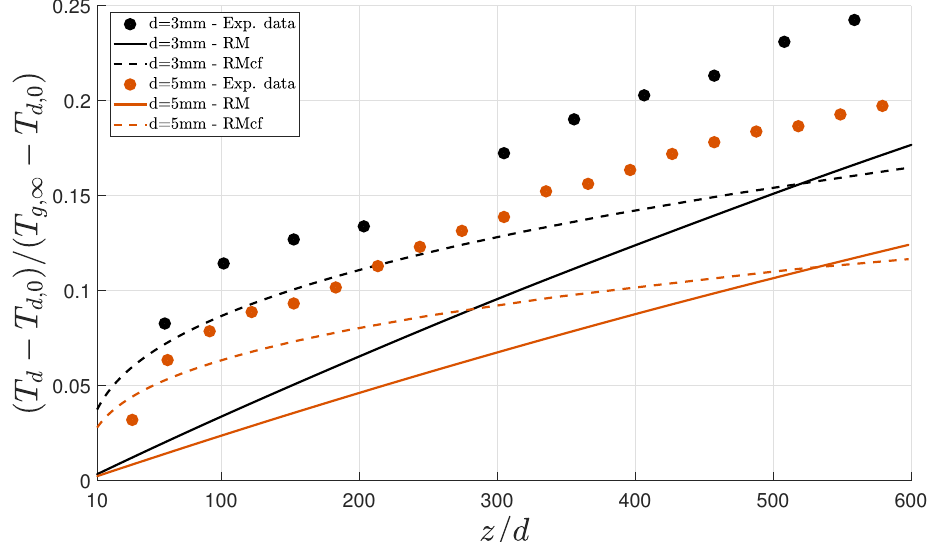
Figure 3. Variation in the temperatures of single water droplets falling through the air, subjected to a humidity ratio of 0.29.